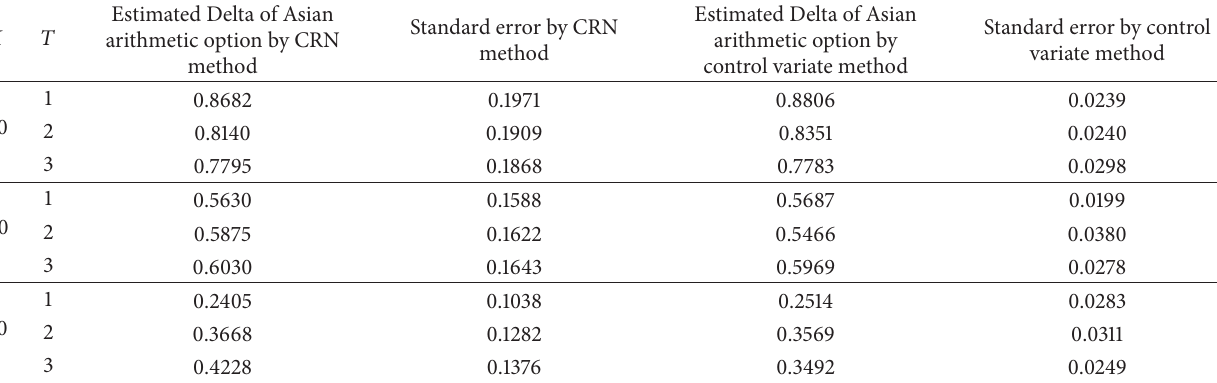
Table 1: Monte Carlo simulation comparison table: common random number method versus control variate method for Asian arithmetic option.